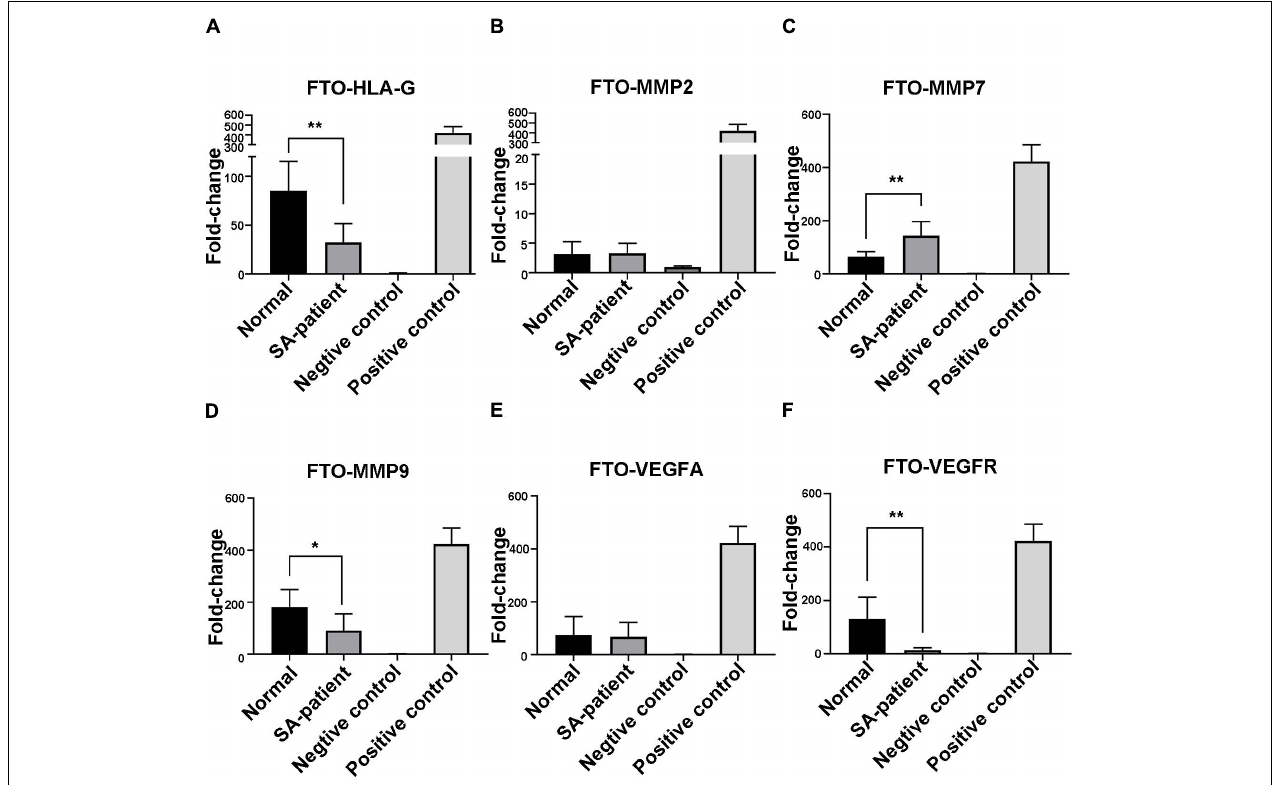
FIGURE 6 | Fold-change in FTO-bound (A) HLA-G , (B) MMP2 , (C) MMP7 , (D) MMP9 , (E) VEGFA , and (F) VEGFR mRNA in the chorionic villi of the indicated groups (Normal n = 9; Patient n = 9, * P < 0.05, ** P < 0.01).